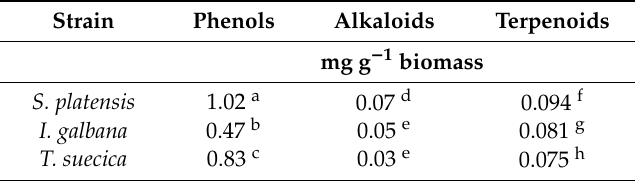
Table 3. Antioxidants concentration in batch cultures. Phenols, alkaloids, and terpenoids content in S. platensis , I. galbana , and T. suecica in batch cultures with a supplied light intensity of 39.63 kJ d − 1 in 9 days’